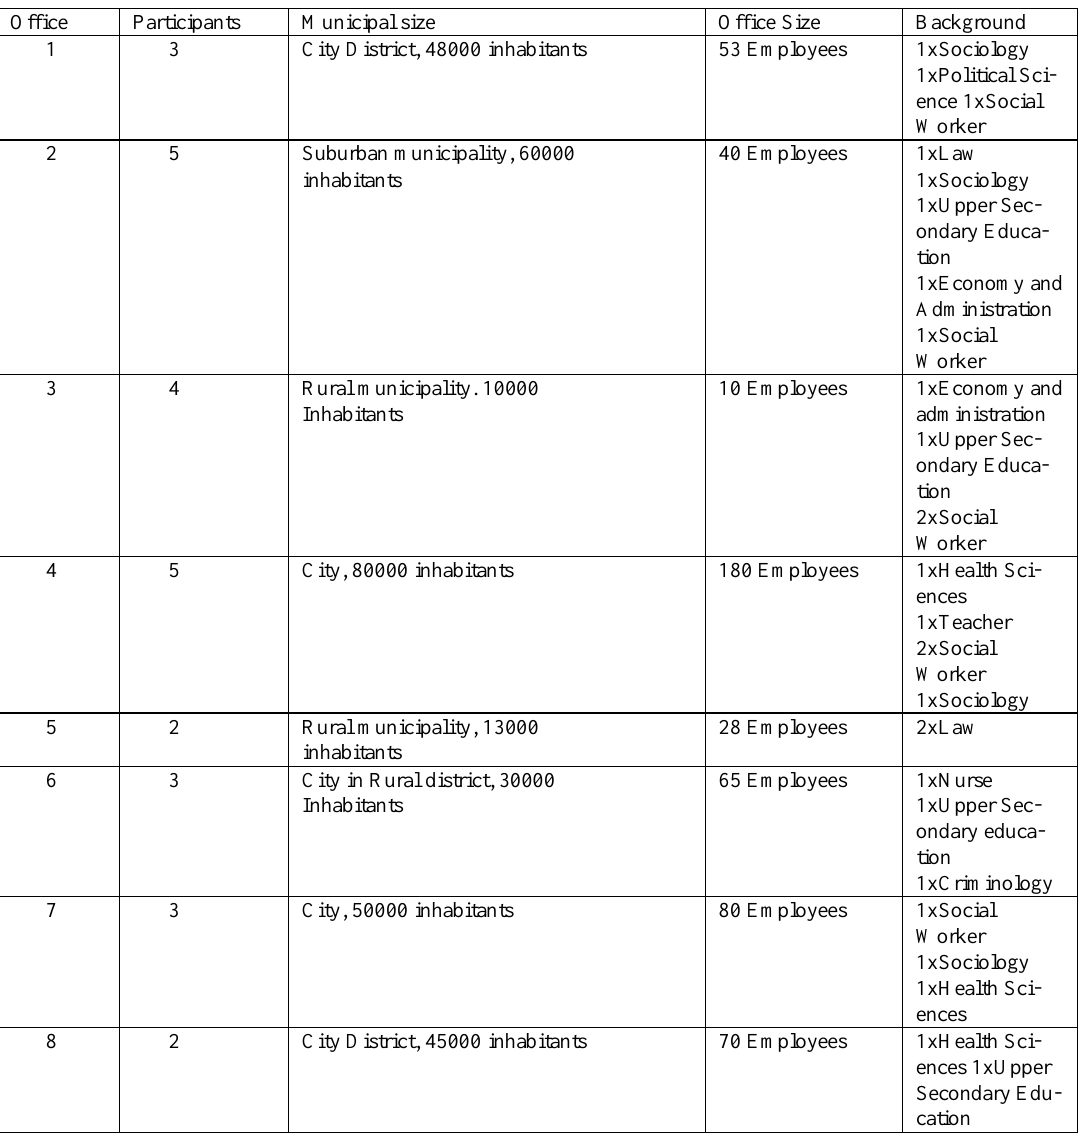
Table 1. Background information on the focus groups and background of partici-